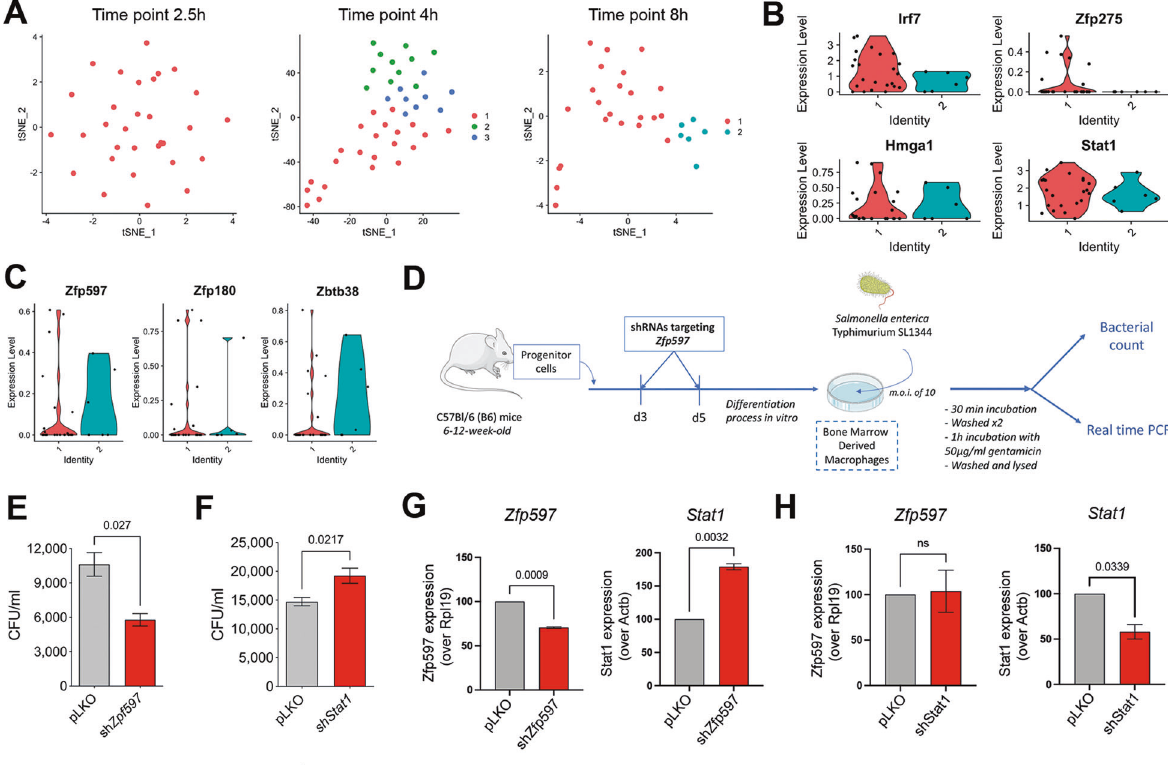
Fig. 4 Immunomodulation of macrophage responses and functional states analysis. A t-SNE displaying functional states identi fi ed by FunPart across three timepoints for macrophages infected by Salmonella typhimurium. B , C Violin plots showing the expression levels for the two functional states identi fi ed at timepoint 8 h of ( B ) the fi rst module composed of Irf7 , Zfp275 , Hmga1 , Stat1 and ( C ) the second module composed of Zp597 , Zfp180 , Zbtb38 . D Summary of the experimental design used to validate Zfp597 and Stat1 as immunomodulators. E – H Differential survival of S. enterica typhimurium in Zfp597 -silenced and Stat1 -silenced macrophages compared to their respective pLKO controls. E , F Colony-forming units recovered from silenced and control-transfected BMMs infected with Salmonella at an m.o.i of 10 for ( E ) Zfp597 and ( F ) Stat1 . G , H Zfp597 and Stat1 gene expression levels in macrophages lentivirally infected with shRNAs targeting the gene or controls (plKO). The results are represented as average ± SE of three independent mice per silencing. The p values were calculated by